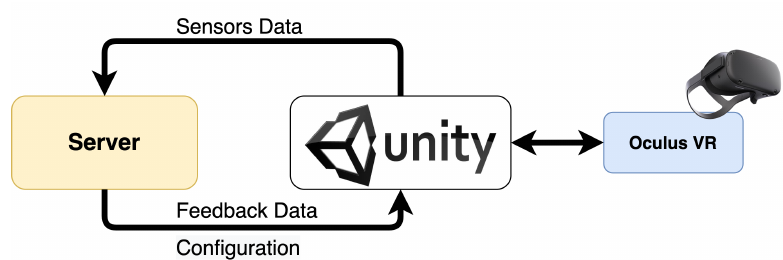
Figure 4. Main components of the virtual reality